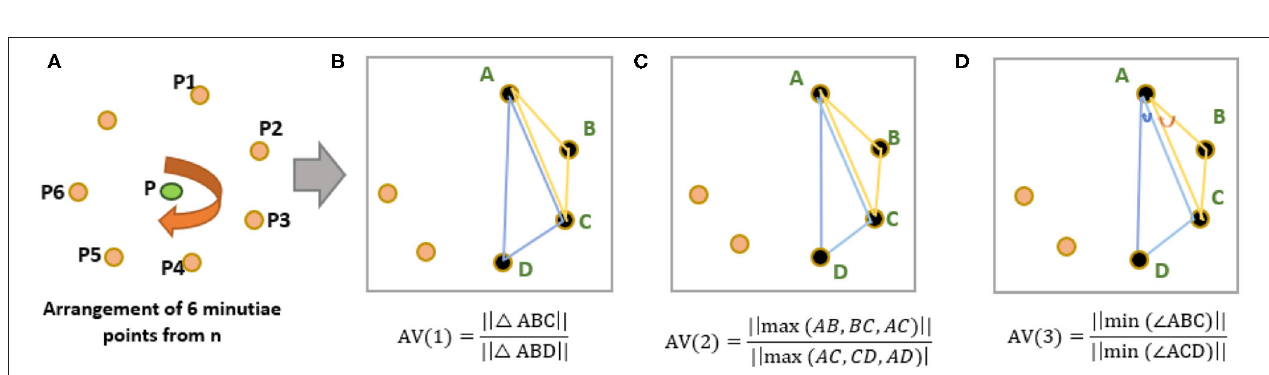
FIGURE 3 | (A) Arrangements of “ m ” nearest minutiae points from n points ( n = 7, m = 6). (B) 1st invariant AV(1). (C) 2nd invariant AV(2). (D) 3rd invariant